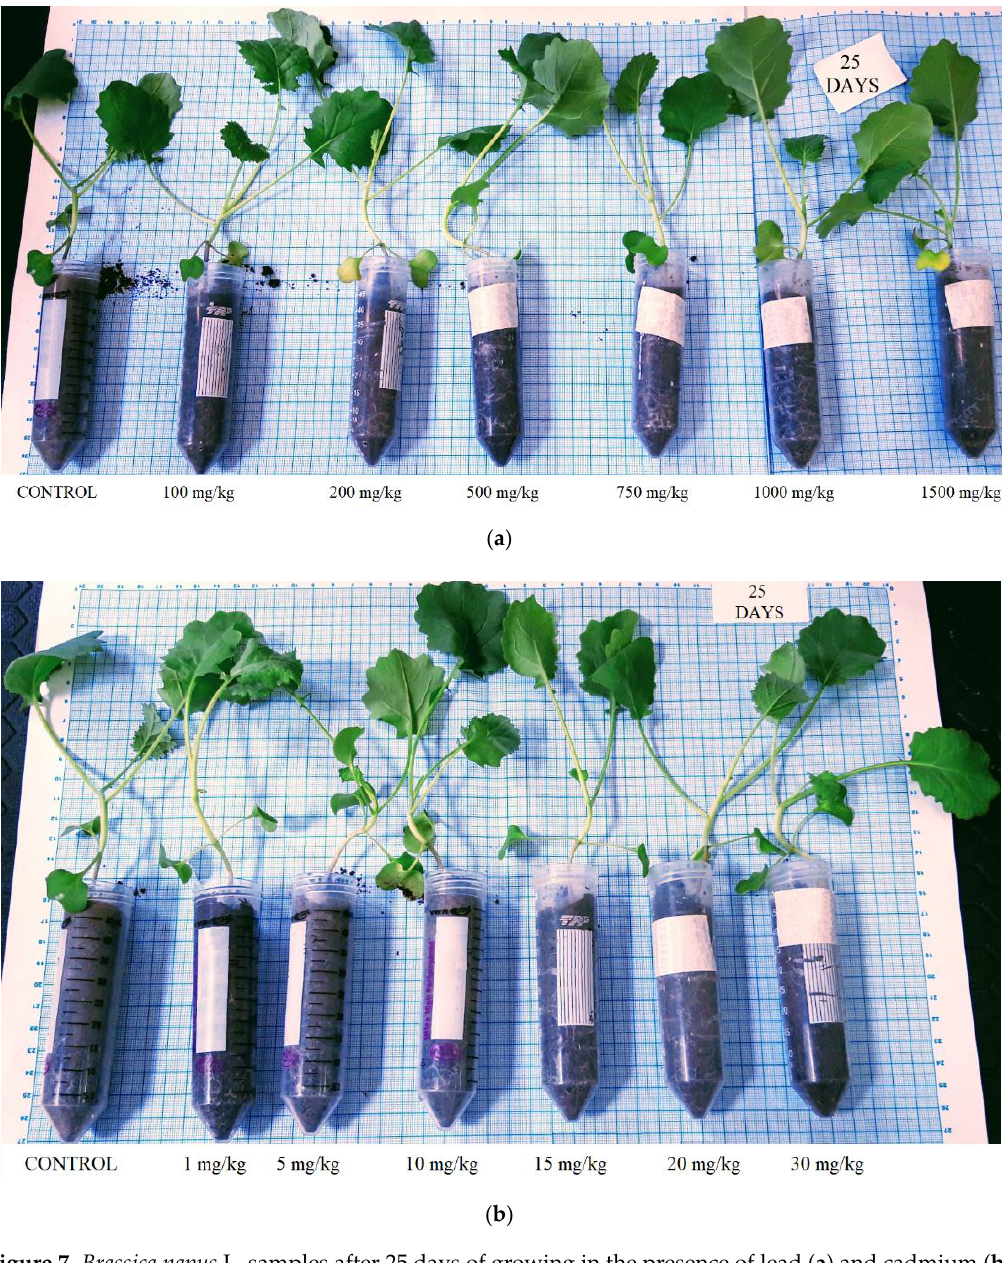
Figure 7. Brassica napus L. samples after 25 days of growing in the presence of lead ( a ) and cadmium ( b ).